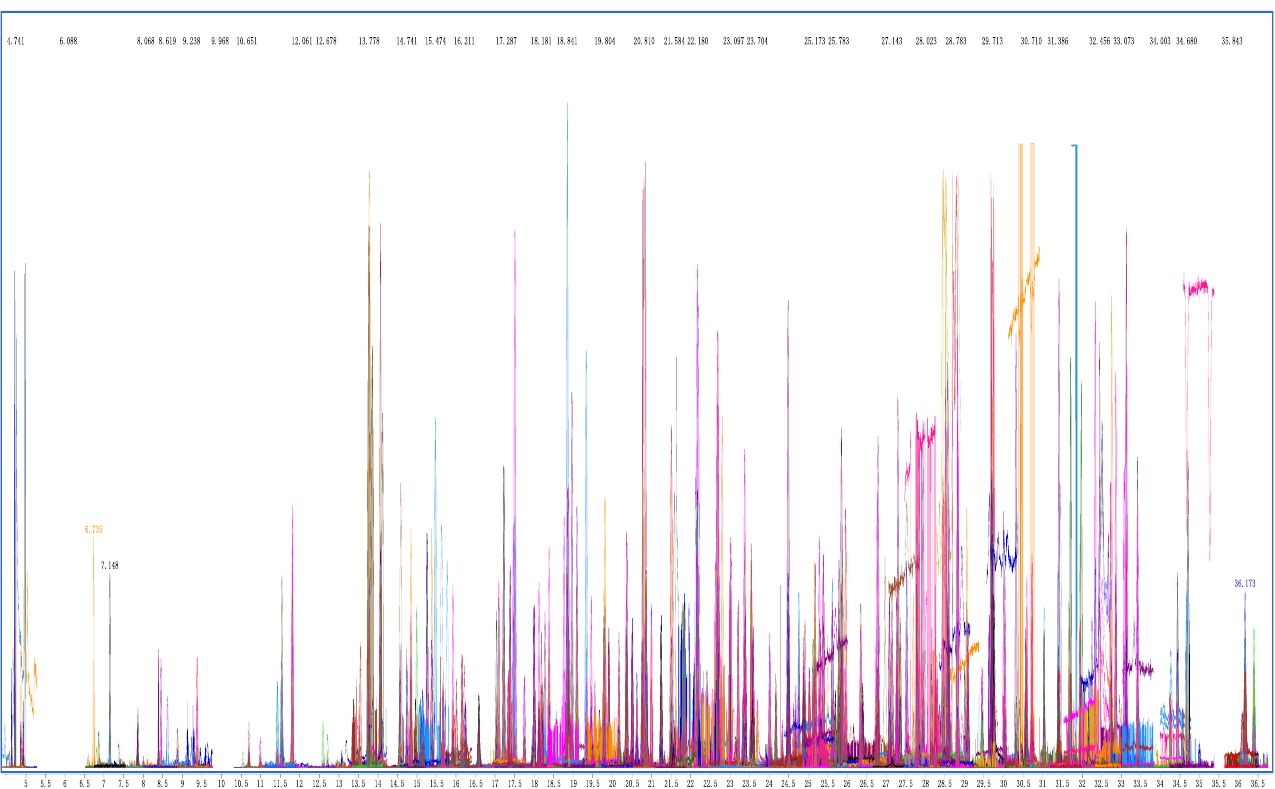
Figure 6. Overlay extraction ion chromatograms of GC-Q TOF/MS of cottonseed hull sample at spiking level of 200 μ g/kg.